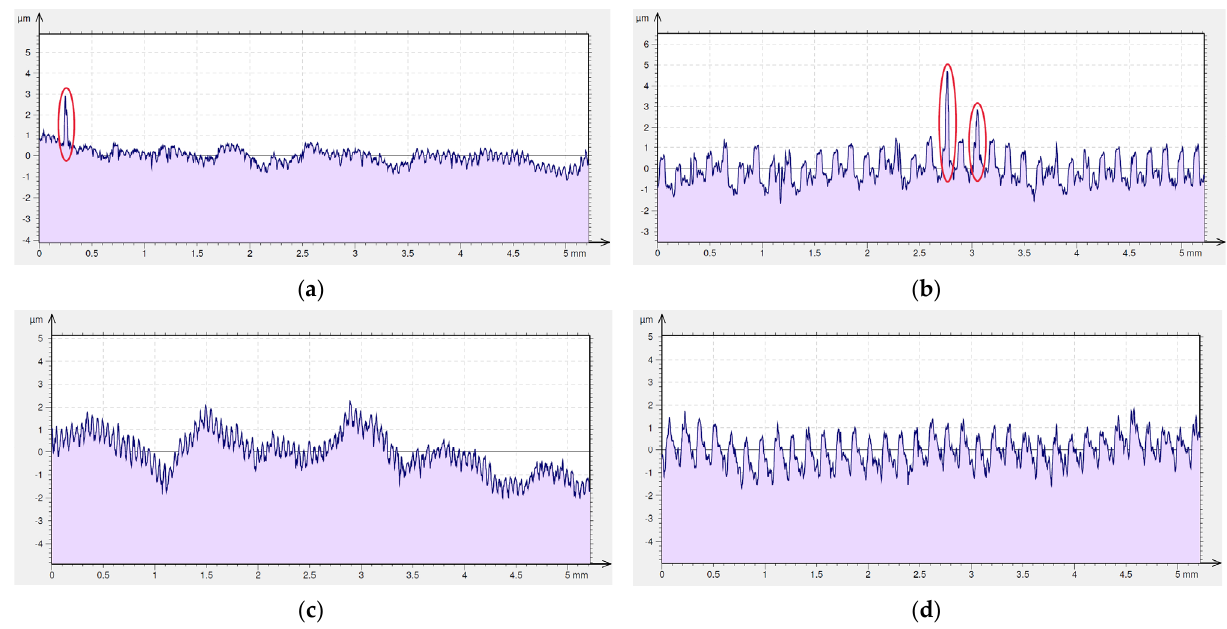
Figure 12. Surface roughness profile of Inconel 718 after turning by the special insert ( the sticking on machined surface is marked by red circle). ( a ) dry cutting, f = 0.05 mm/rev; ( b ) dry cutting, f = 0.15 mm/rev; ( c ) wet cutting, f = 0.05 mm/rev; ( d ) wet cutting, f = 0.15 mm/rev.